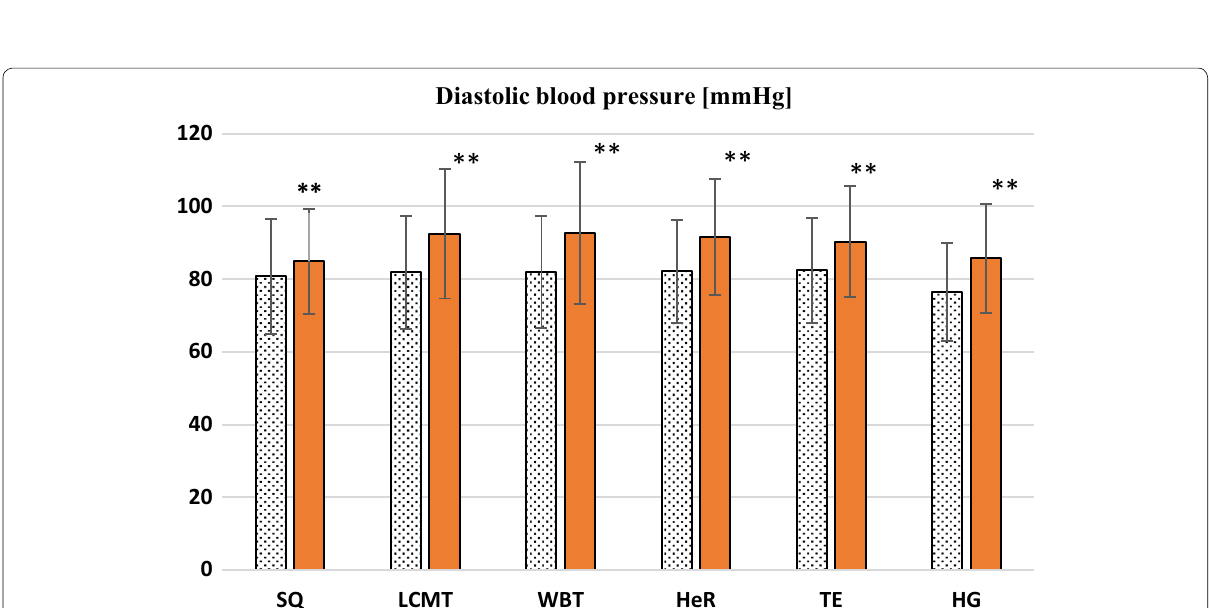
Fig. 2 Increase in diastolic blood pressure during ICM. ** p < 0.001, SQ squatting, LCMT leg crossing and muscle tensing, WBT whole-body tensing, He heel raising, TE toe extension, HG